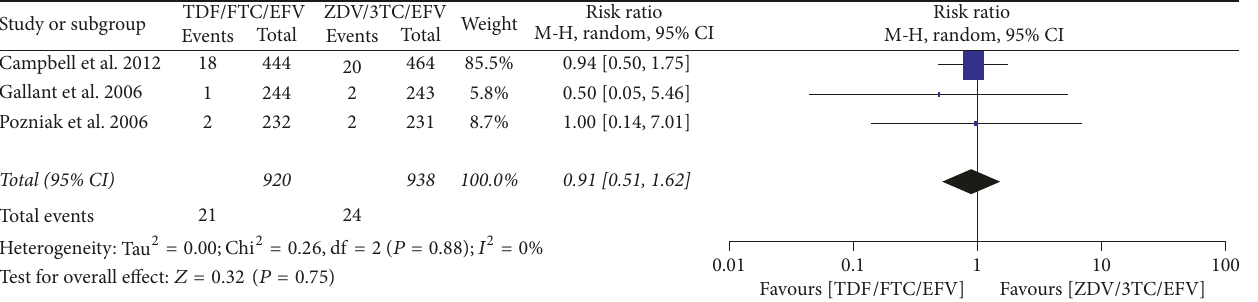
1858 participants for determining efficacy, tolerability, and mortality,